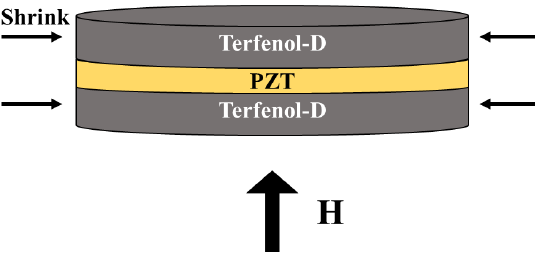
Figure 10. Sketch of the magnetoelectric heterostructure proposed in [119]. Two Terfenol-D disks actuate a PZT disk after undergoing a shrink due to the applied magnetic field.